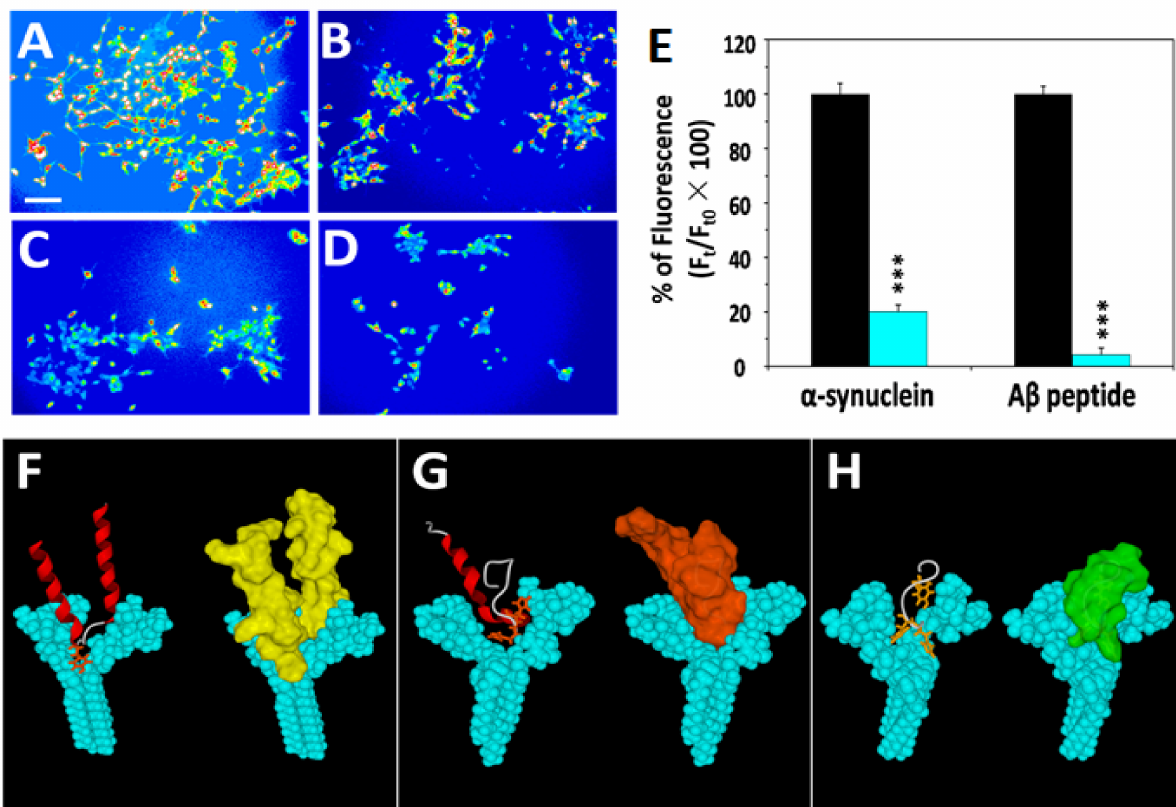
Figure 2. Resistance of transfected cells to amyloid pore formation by α -syn and A β . ( A , B ) Non-transfected SH-SY5Y cells. ( C ) SH-SY5Y-AmyP53 cells incubated with A β 1–42. ( D ) SH-SY5Y-AmyP53 cells incubated with α -syn. In these experiments, the cells were first loaded with Fluo-4AM and Ca 2+ -dependent fluorescence was measured 60 min after injection of A β 1– 42 peptide ( A , C ), or 75 min after injection of α -syn ( B , D ) at a concentration of 220 nM. The images show pseudocolor representations of cells (scale bar: 100 µ m), with warmer colors corresponding to a higher fluorescence. The pictures are representative of three independent experiments. ( E ) Results in the histogram are expressed as mean ± SEM. Student’s t -test was used to compare the statistical significance of fluorescence between non-transfected and SH-SY5Y-AmyP53 cells + α -syn (*** p < 0.0005 with 52 < n < 95) or + A β (*** p < 0.0005 with 111 < n < 151). ( F – H ) Molecular modeling of ganglioside- α -syn ( F ), ganglioside-A β ( G ) and ganglioside-AmyP53 ( H ) complexes. In each case, two views of the molecular complex are shown, with the ganglioside dimer colored in cyan and the ligand ( α -syn, A β 1–42 or AmyP53) in secondary structure ( left panels ) and surface ( right panels ) rendition. The lateral chains of tyrosine ( F ) and histidine ( G , H ) residues are represented. These amino acids are deeply inserted in the chalice formed by the dimer of gangliosides. In addition, note how the pair of histidine residues of AmyP53 (H13–H14) clamps the peptide on the ganglioside dimer, resulting in tighter interaction compared with α -syn or A β . The third histidine residue of AmyP53 interacts with the glycone part of the ganglioside on the right side of the